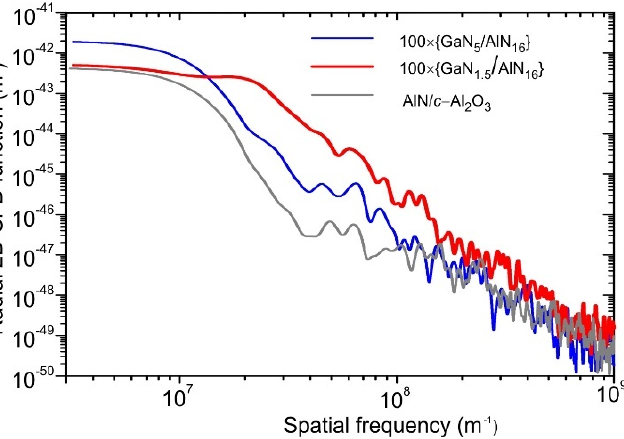
Figure 3. Radial 2D-spectral power densities as functions of surface frequency of the AlN template and MQW structures calculated from their AFM images measured in a scanned area of 1 × 1 µm 2 .